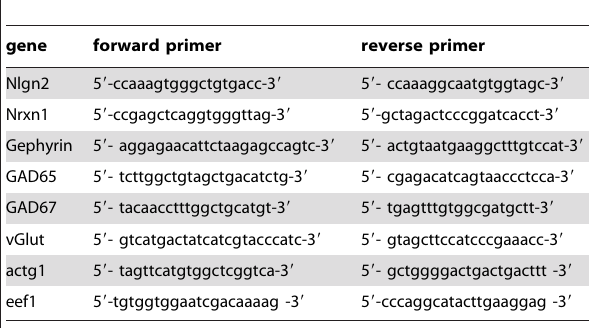
Table 1. primer sequences for